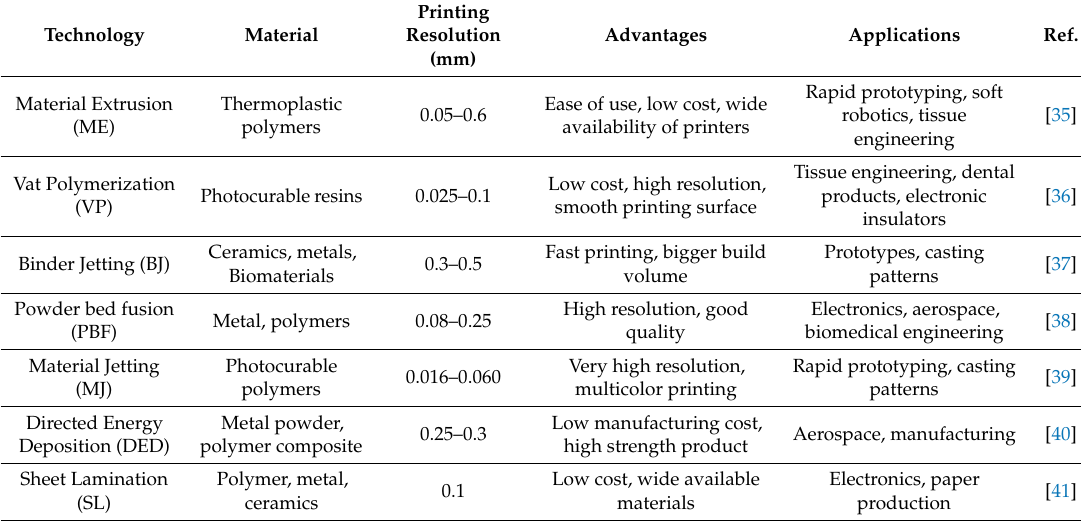
Figure 1. Additive manufacturing technologies category adapted from [33,34]. Table 1. The advantages AM technologies of polymer-based materials and its potential applications.